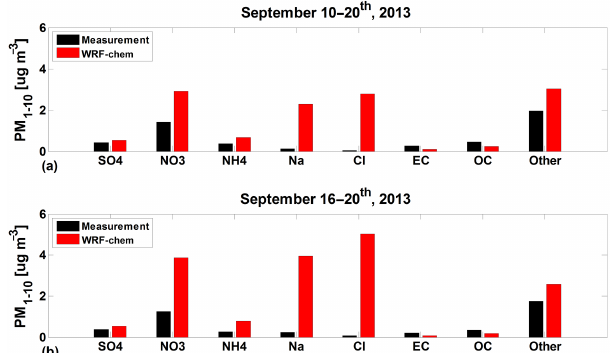
Figure 5. Comparison of coarse-mode aerosol (PM 1 − 10 ) chem-